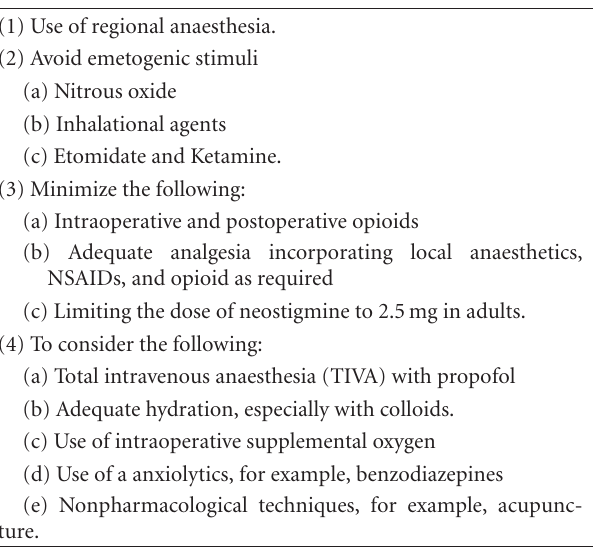
Table 1: Anaesthetic strategies to decrease